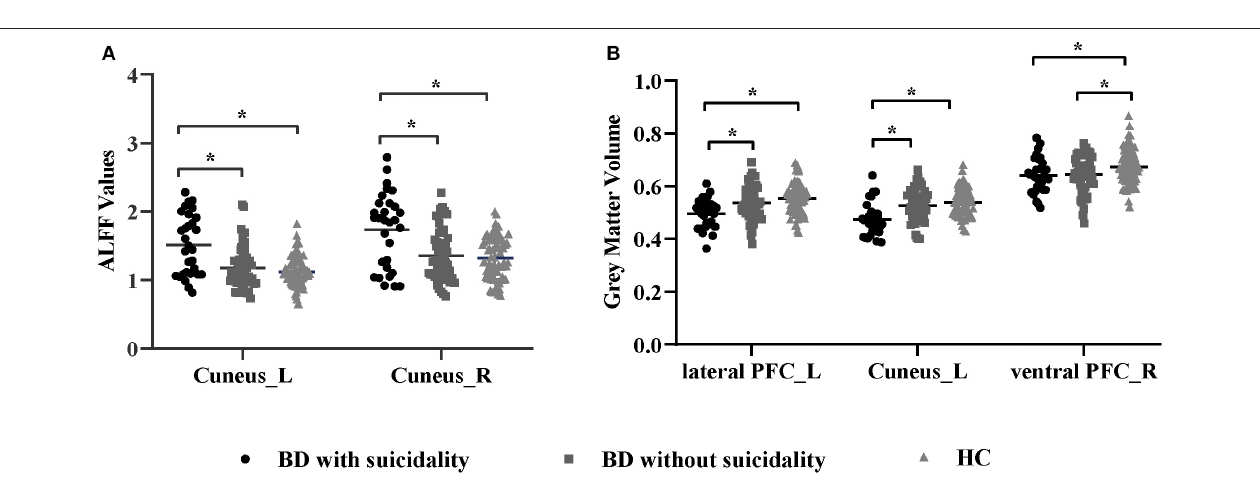
FIGURE 2 | Significantly alteration of gray matter volume in (A) left lateral PFC, (B) left cuneus and (C) right ventral PFC across the BD with suicidality, BD without suicidality, and healthy controls groups. The significance level was set to P < 0.001 by Gaussian random field correction. The color bar indicates the t -values. BD, bipolar disorder.